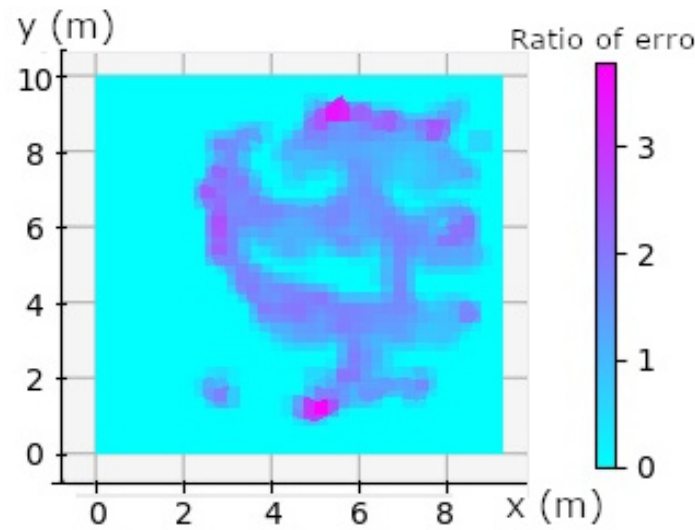
Figure 10. Speed diagram in m/s. Brown rectangles are each rig, the two of the top are the supply rig. Purple values are area with maximum speed and cyan are are with no data.